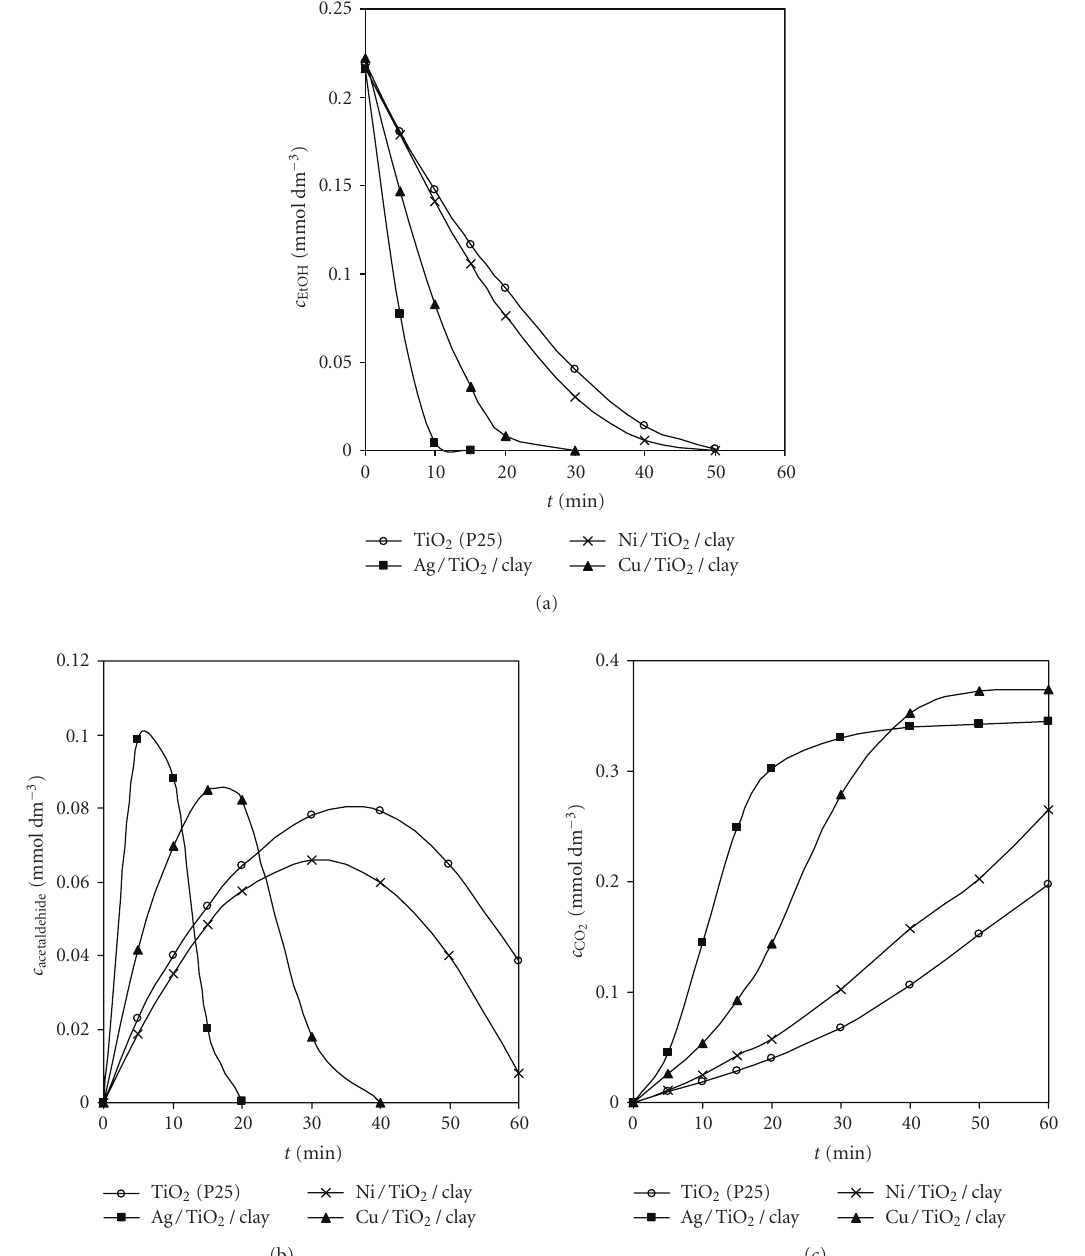
Figure 4: Ethanol concentration changes under (a) UV-Vis irradiation (light source 1), (b) kinetic curves of acetaldehyde, and (c) CO 2